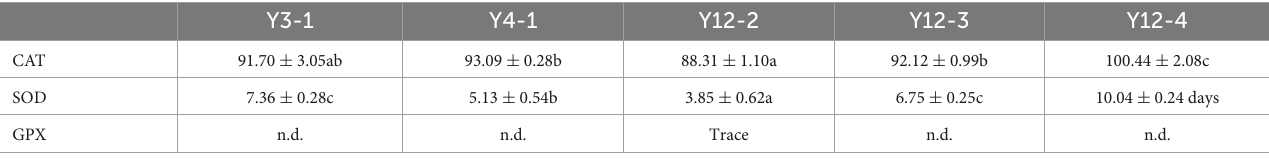
TABLE 1 The main antioxidant enzyme activities in the broken cell-free extracts ( U/mg protein ).